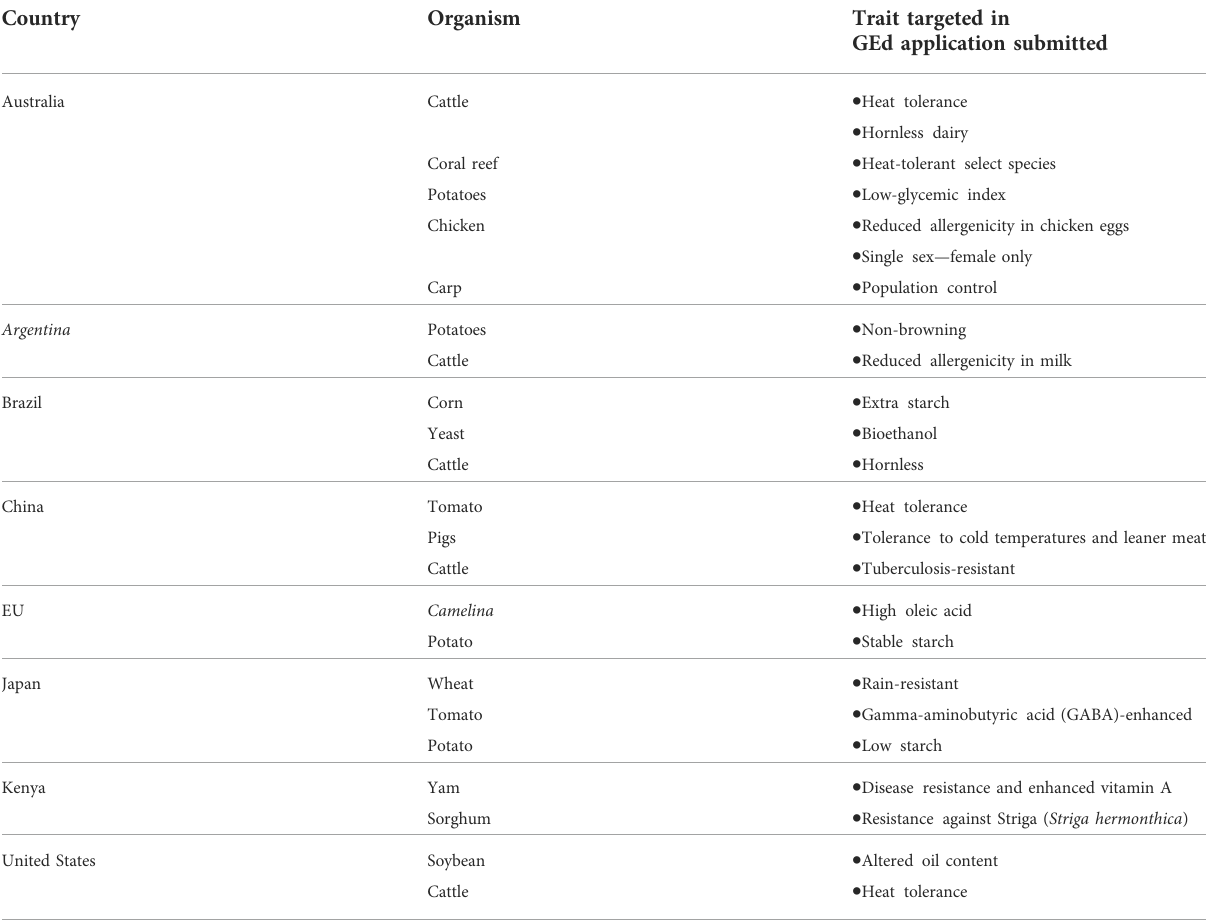
TABLE 2 Summary of the GEd applications improving sustainability and nutritional value traits, submitted to selected regulatory